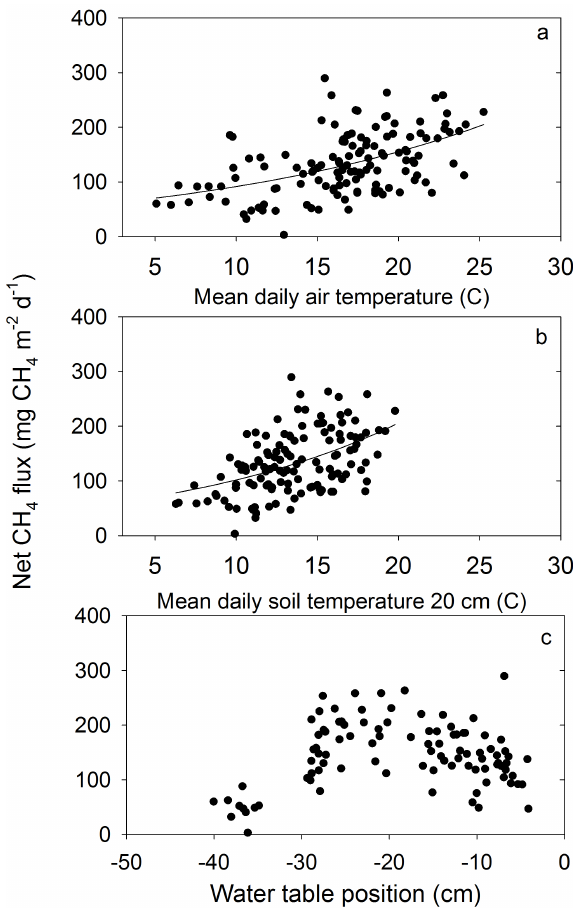
Fig. 4. Relationship between mean daily air temperature, mean daily soil temperature, water table position and the net daily CH 4 flux. There were significant exponential relationships between mean daily soil temperature (50 . 3exp 0 . 070 x , R 2 = 0 . 23, p value < 0.0001) and mean daily air temperature (53 . 9exp 0 . 05 x , R 2 = 0 . 25, p value < 0.0001). Positive CH 4 flux values represent fluxes to the atmosphere and negative values represent losses from the at- mosphere.